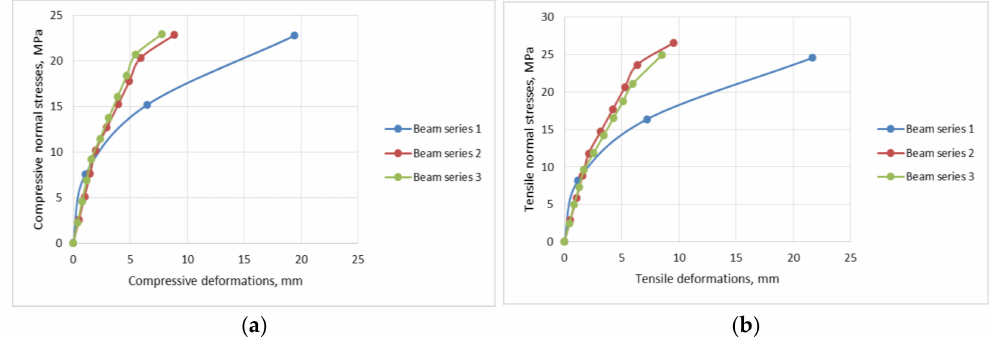
Figure 9. Stress–deformation relationships under compression ( a ) and tension ( b ) for the beams of different